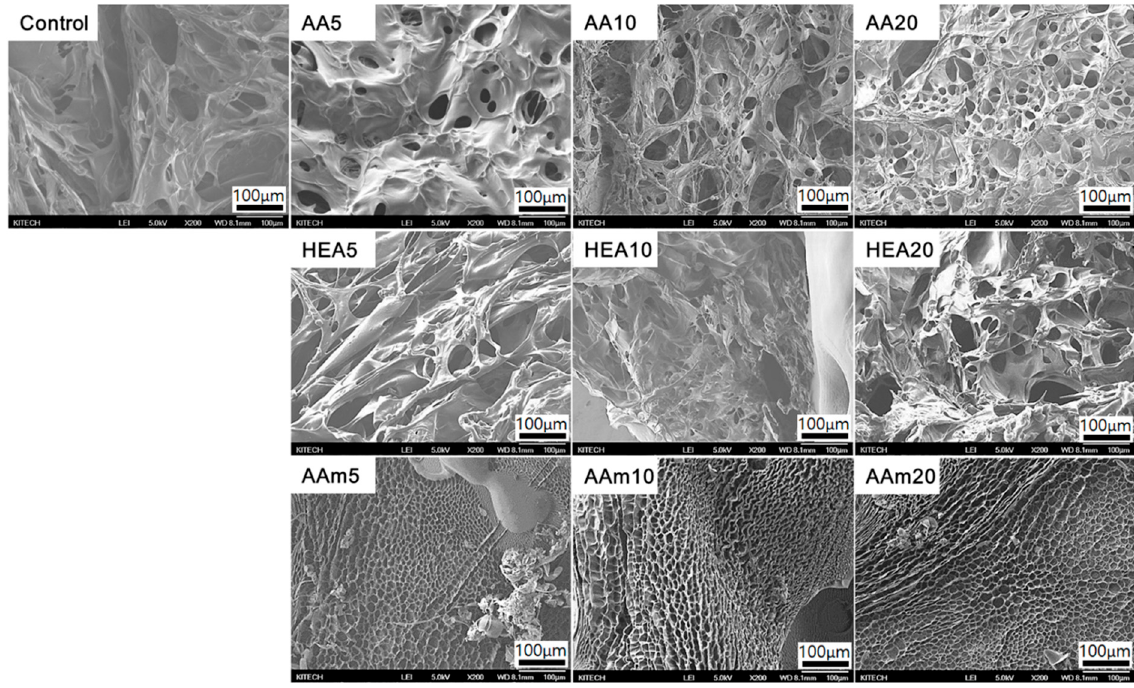
Figure 8. SEM images of fracture surfaces of AMPS hydrogels modified with different comonomers; magnification: ×200.